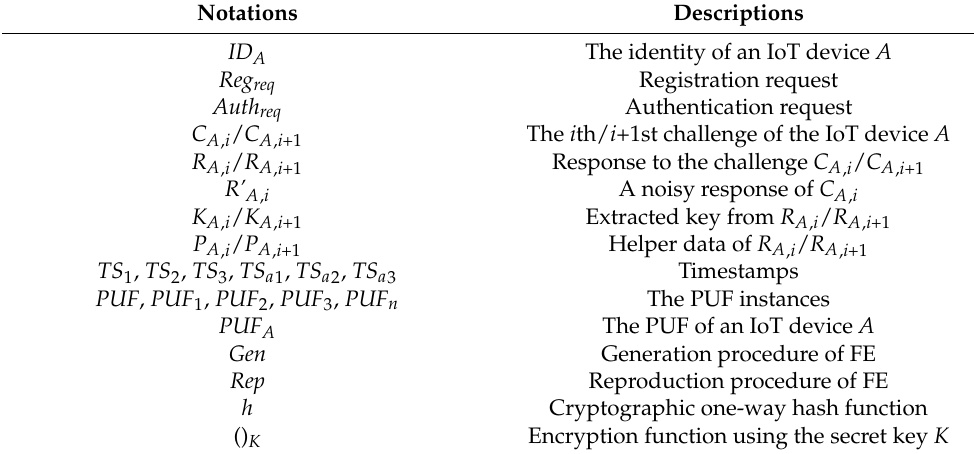
Table 1. Used Notation.